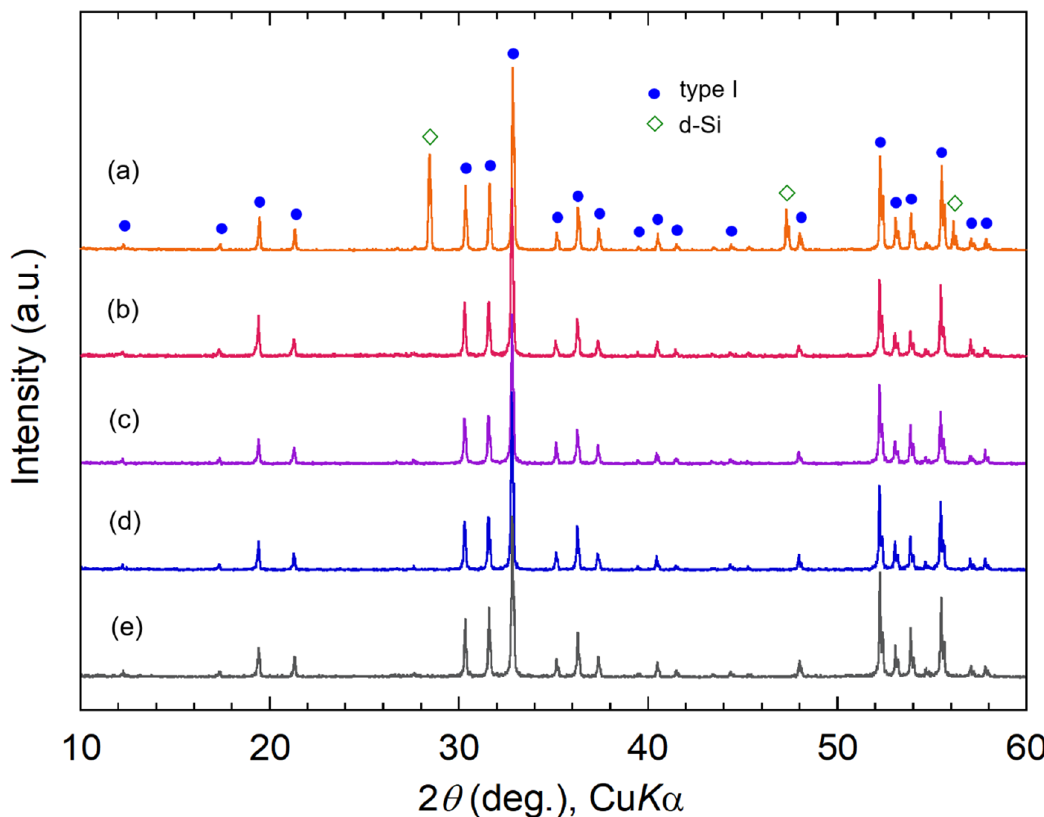
Figure 2. XRD patterns of the samples prepared by heating the Na–Si–Sn solution at 723 K and x values of ( a ) 0, ( b ) 0.1, ( c ) 0.25, ( d ) 0.5, and ( e ) 1.0. The Na–Sn fluxes were removed by the ethanol and nitric acid treatments.